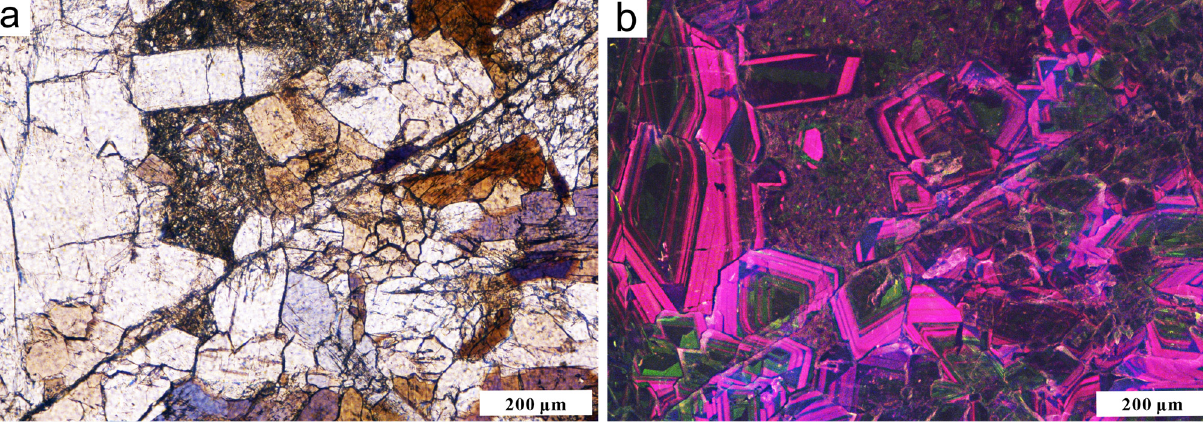
Figure 5. Rhythmic zoning patterns (RZPs). ( a ) Photo under cross-polarized light. ( b ) The same parts show clear RZPs under cathodoluminescence.